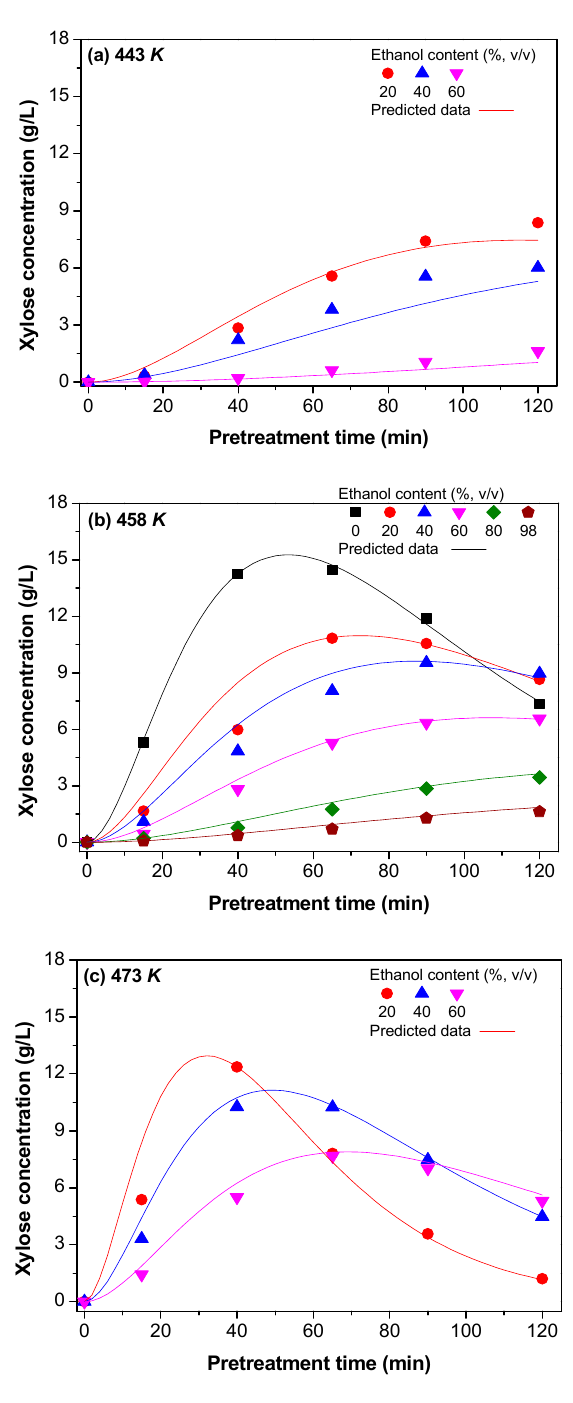
Figure 3. Measured and predicted xylose formation at EACO pretreatment temperature of ( a ) 443, ( b ) 458 and ( c ) 473 K with different ethanol content (%, v/v) in pretreatment liquor.